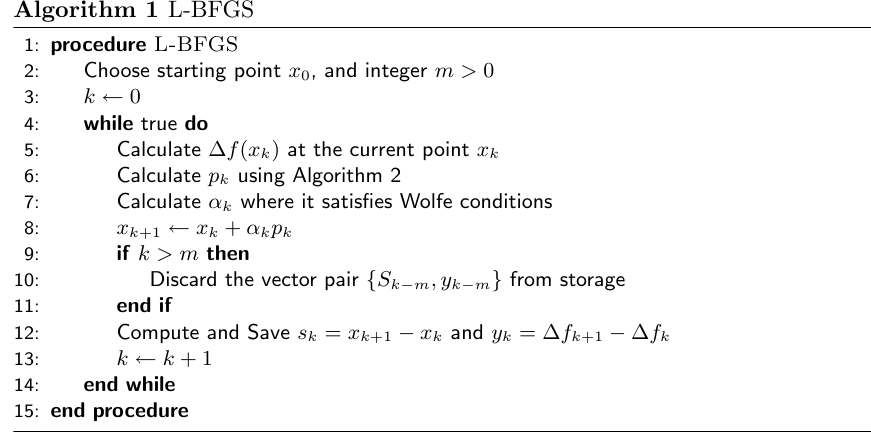
Algorithm 1 L-BFGS